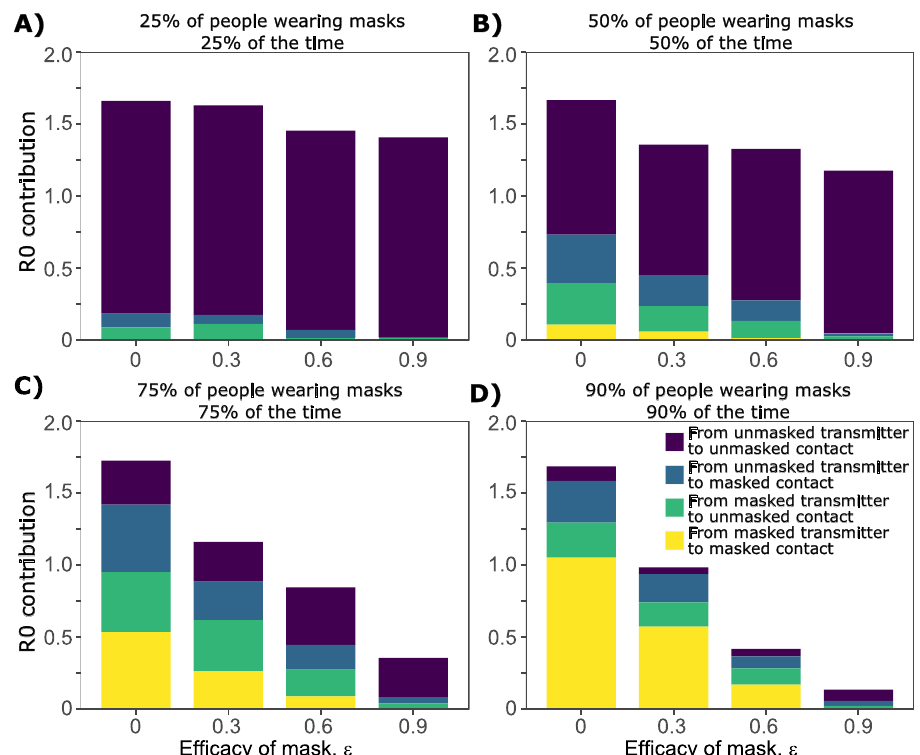
Figure 4. Effect of mask utilization and efficacy on proportion of masked transmissions contributing to total R 0 . Each panel includes simulations of 3000 transmitters with varying daily exposure contacts and ( A ) low ( B ) moderate ( C ) high, and ( D ) near-perfect mask usage. Specifics of mask use are noted in panel